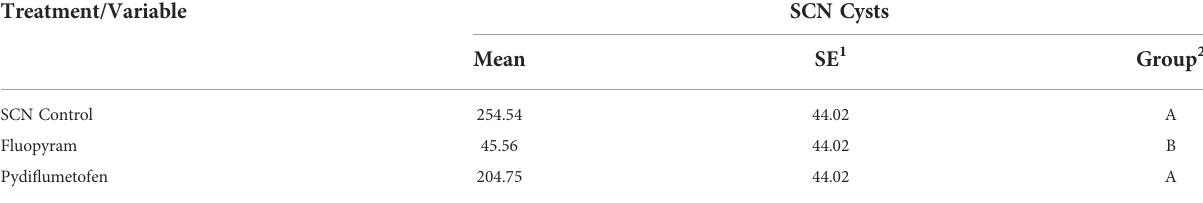
TABLE 5 Number of SCN juveniles per gram of root following seed treatment with fl uopyram and pydi fl umetofen (P=0.0112).